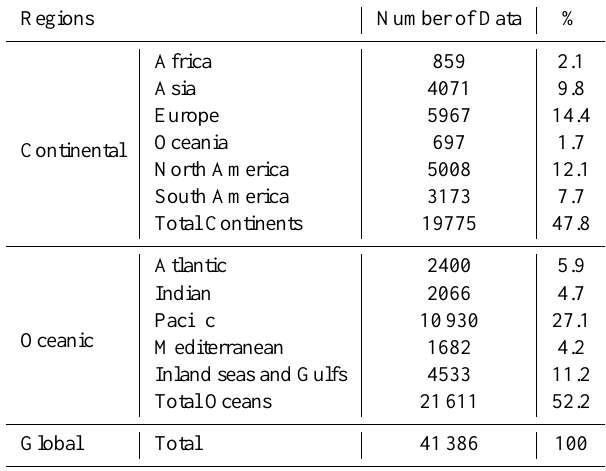
Table 1. Summary of updated global heat flow data (Derived from Vieira and Hamza,